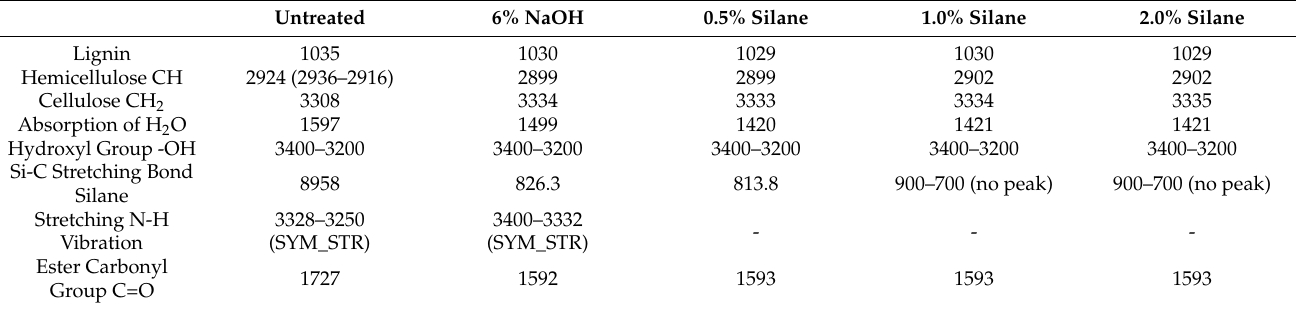
Figure 9. Fourier Transform Infrared Spectrometry (FTIR). Table 5. Parameter of extrusion.